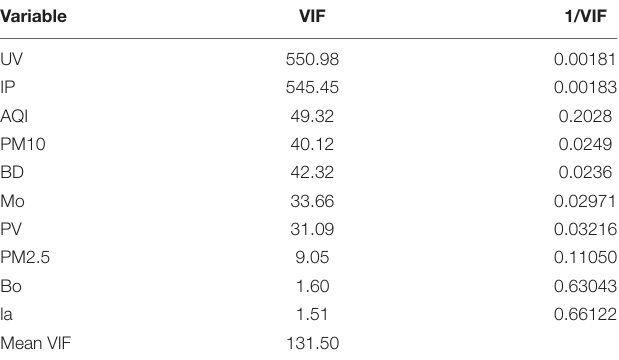
TABLE 2 | VIF test